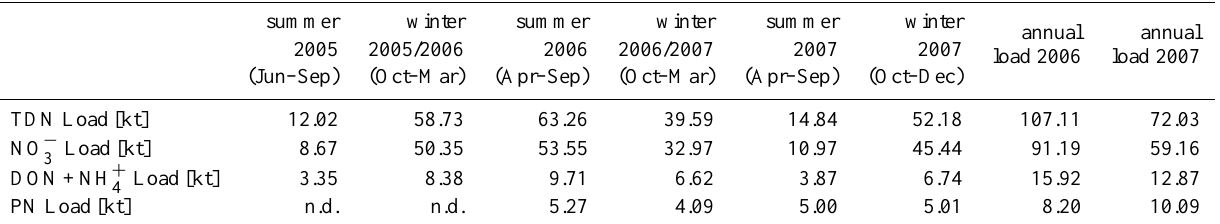
Table 3. Annual and seasonal loads (in kt) of nitrate, TDN, DON+NH + December 2007 (n.d.=not determined).